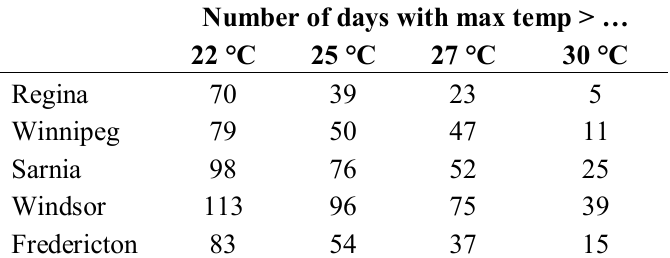
Table 3. Number of hot days by city between 1 May and 10 September 2010.